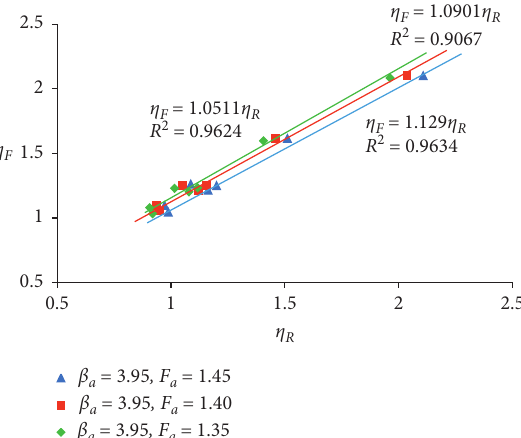
Figure 11: The correlation of η